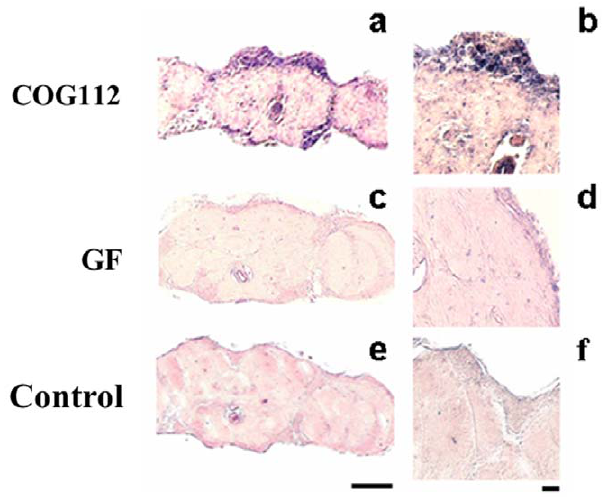
Figure 4. In vivo delivery of peptides into Drosophila brain. Immunohistochemistry with antibody to biotin: Left panels - Bar, 50 m m; Right panels-Bar, 10 m m. a,b - Antp-COG133 (COG112) - RQIKIWFQNRRMKWKK LRVRLASHLRKLRKRLL. c,d- CF (fragment 142– 153 of human growth factor U2AF)-SQMTRQARRLYV, control peptide, which does not cross BBB [33]; e,f – no peptides